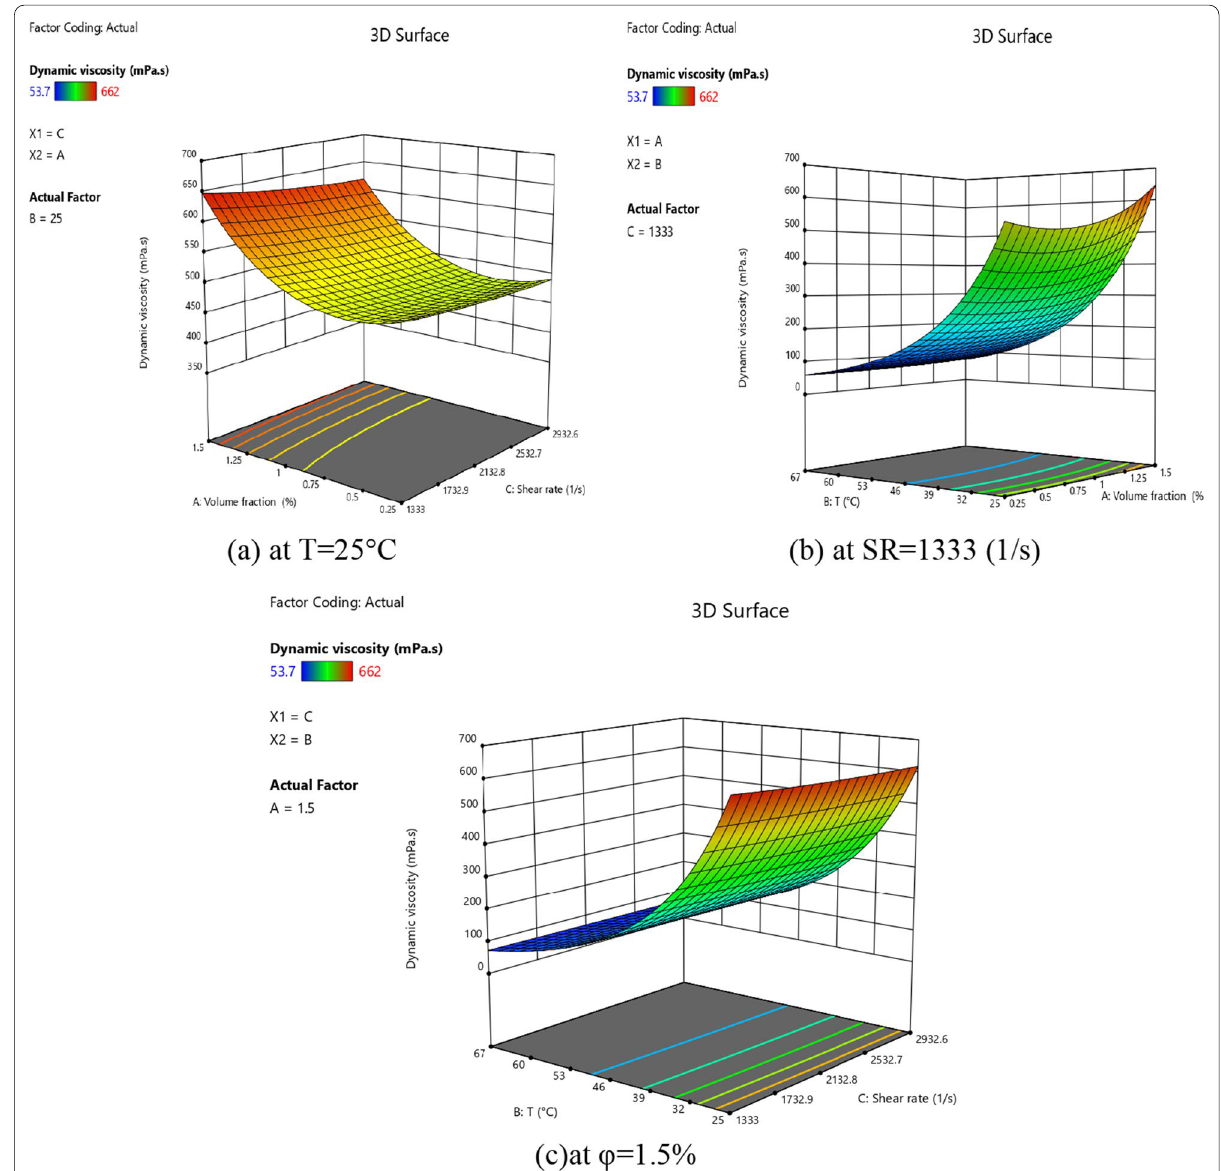
Fig. 16 Interaction within a SR and NPSVF, b ) T and NPSVF, and c T and SR on viscosity by